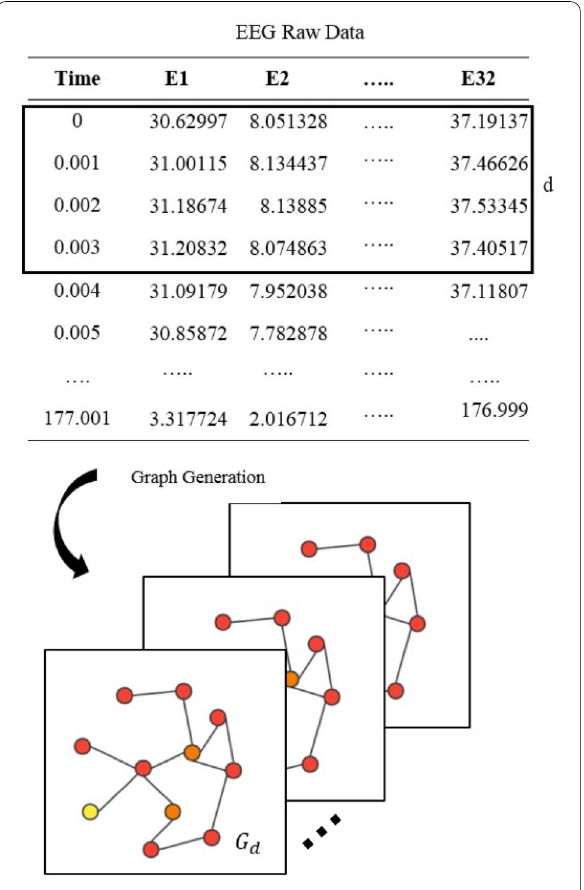
Fig. 1 The structure generation of EEG data, where the data at the range of time d forms a